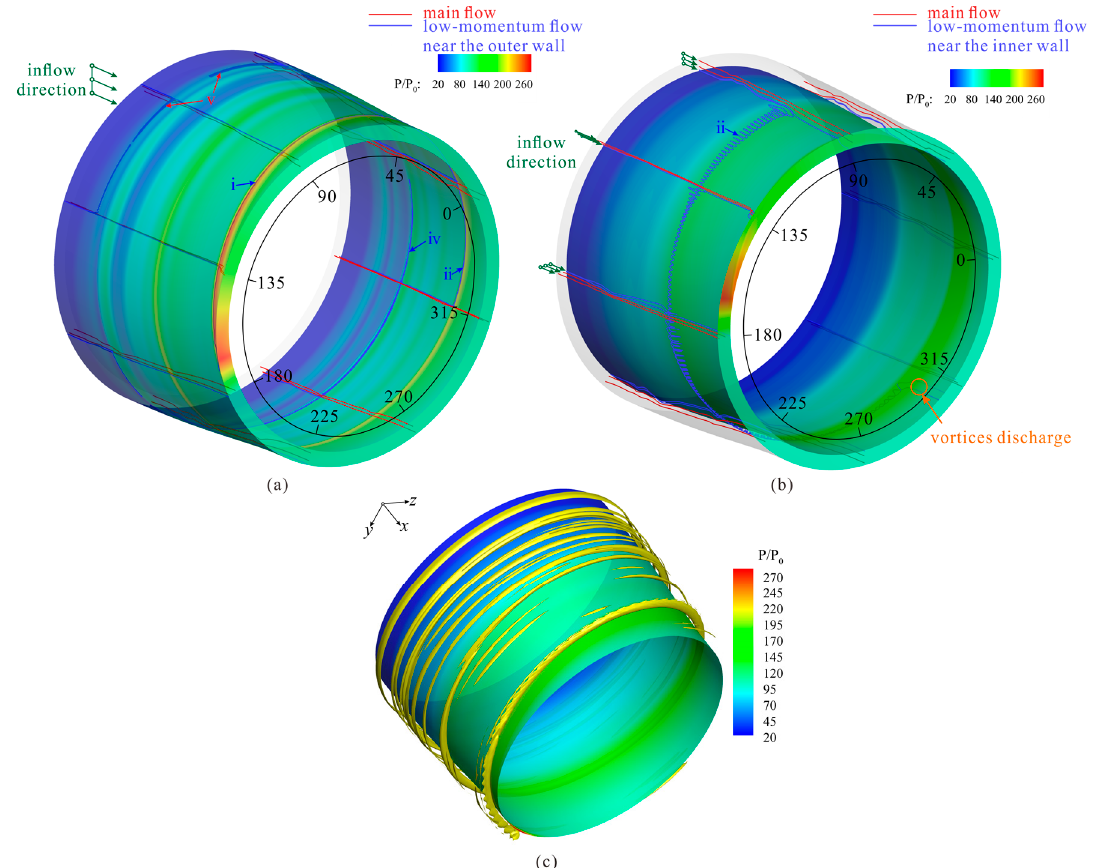
Figure 9. Vortex structures originate. ( a ) Three-dimensional streamlines released from the entrance at eight angles without the vicinity of the inner surface. ( b ) Three-dimensional streamlines released from the entrance at eight angles without the vicinity of the outer surface. ( c ) Three-dimensional vortices and the inner-wall pressure contour.